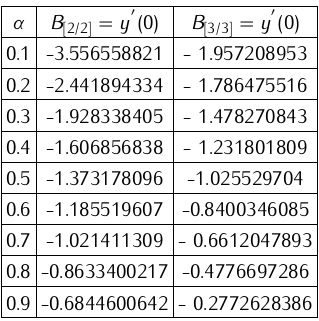
0 = u (0) for various values of α